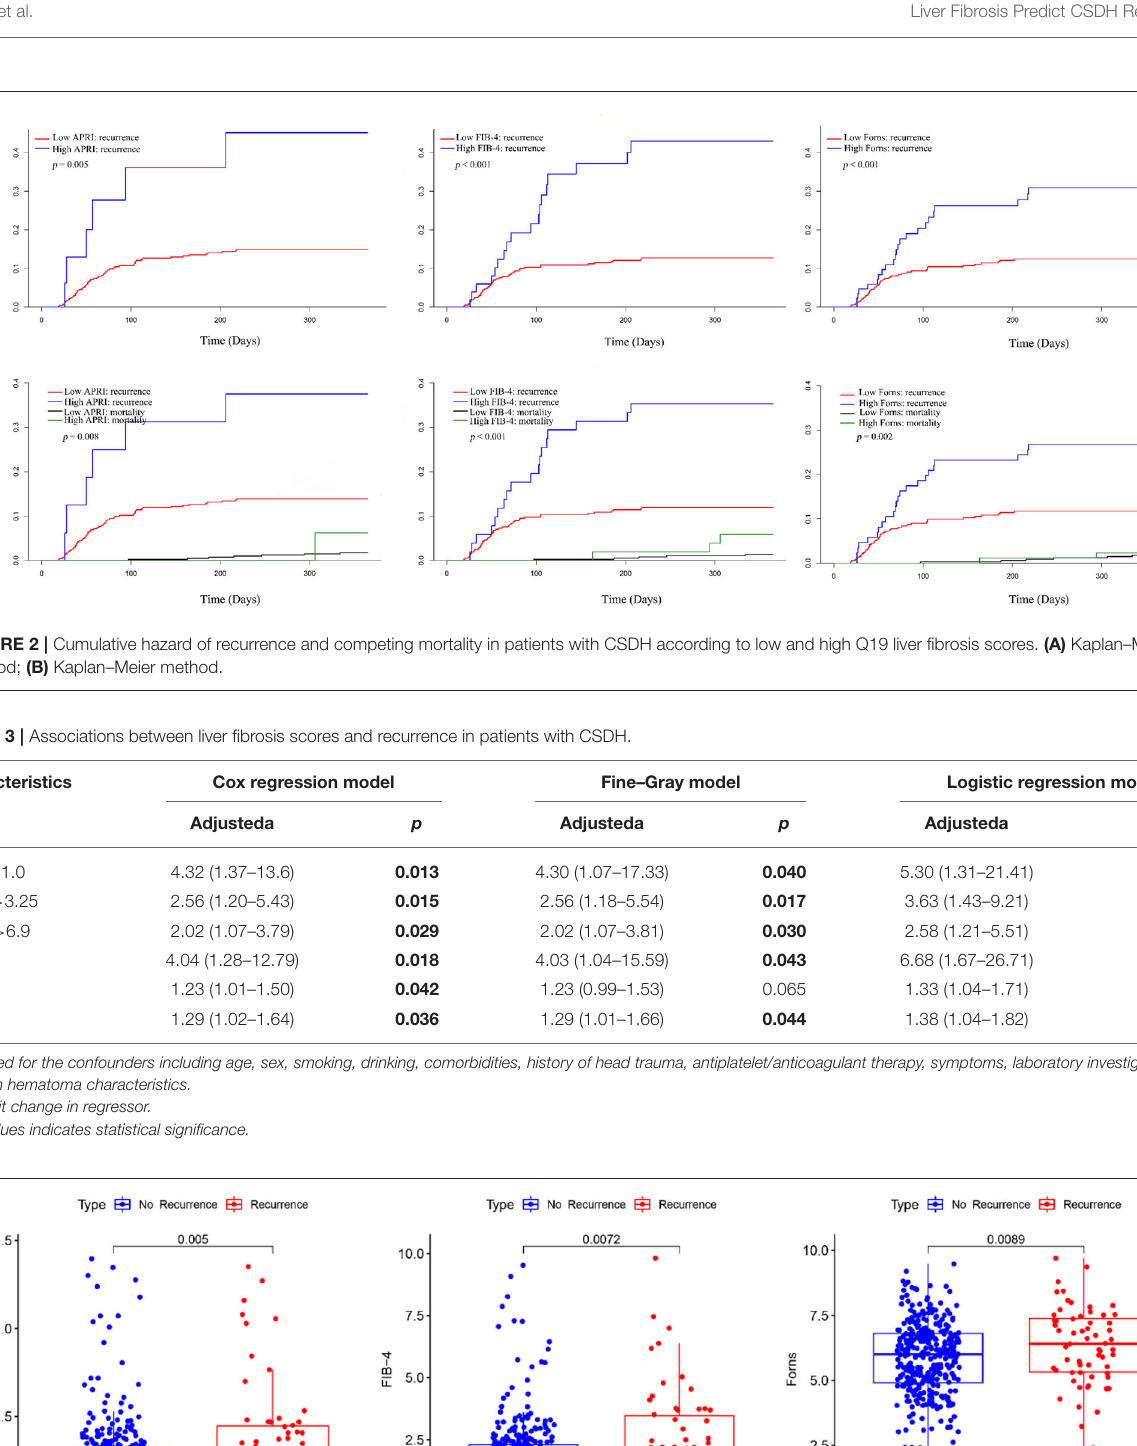
CSDH recurrence, we evaluated the effect of adding them to multiparameter CM, respectively. As shown in Table 5 , the